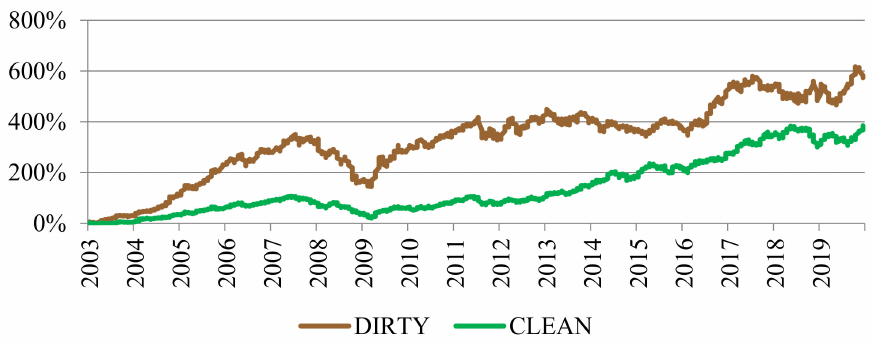
Figure 1. Cumulative rate of return on DIRTY and CLEAN portfolios 2003–2019.